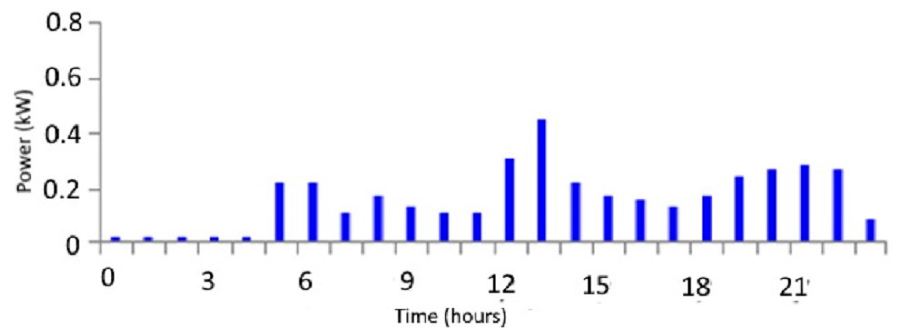
Figure 6. Daily load curve